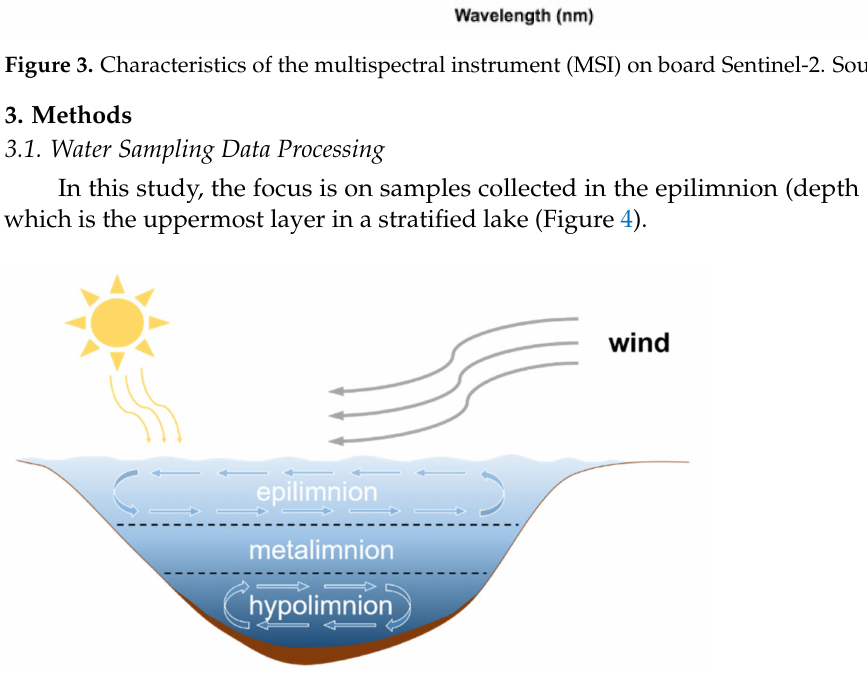
Figure 4. Lake stratification